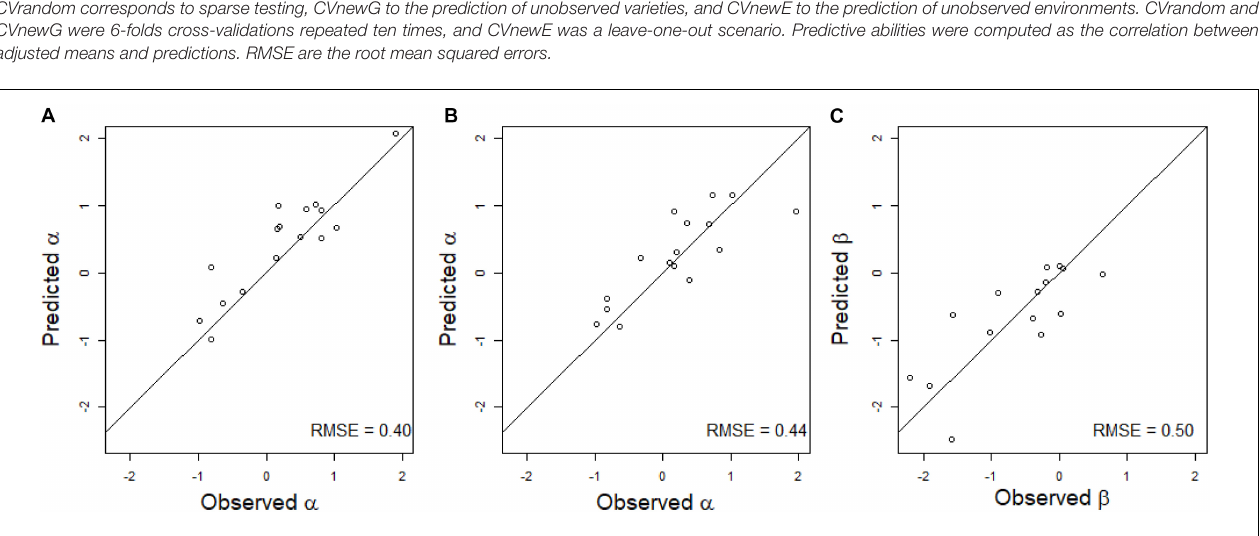
and 0.50 for β ( Figures 3B,C ). For β , the sign of the regression was inaccurately predicted for three